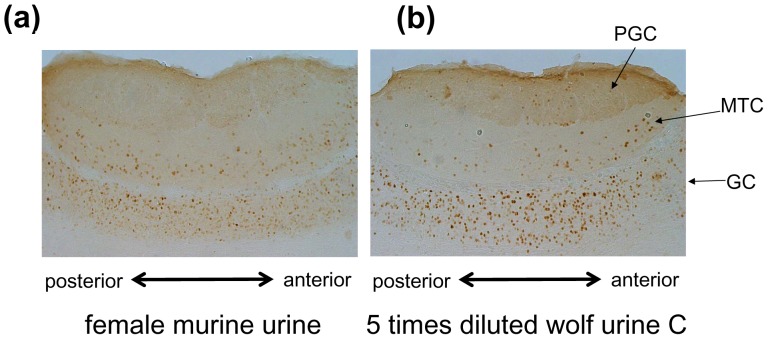
Sagittal section of the AOB of female mice stained with an antibody against Fos after exposure to female murine urine (A) or 5-fold diluted wolf urine sample C (B).PTC, periglomerular cell layer; MTC, mitral cell layer; GC, granule cell layer.